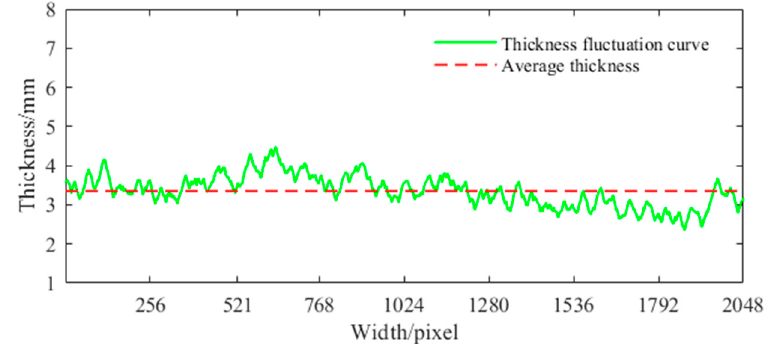
Figure 5. Variation of fabric thickness.